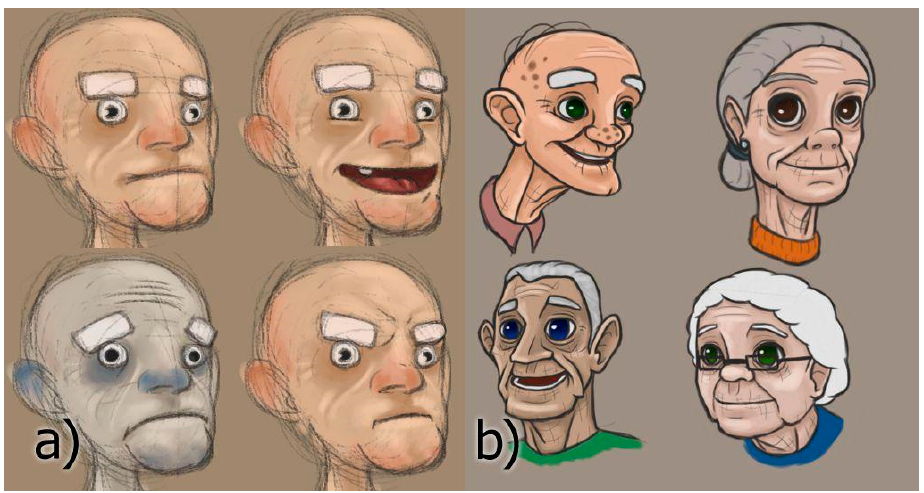
Figure 5. ( a ) Initial character concepts. ( b ) Final character concepts.